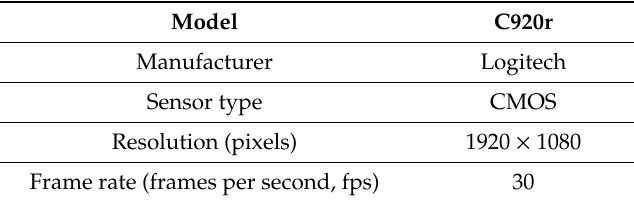
Table 2. Specifications of the selected webcam.